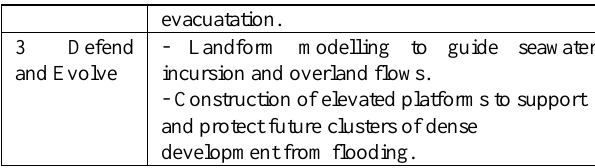
Table 4: Adaptation scenarios and strategies for Gosford.